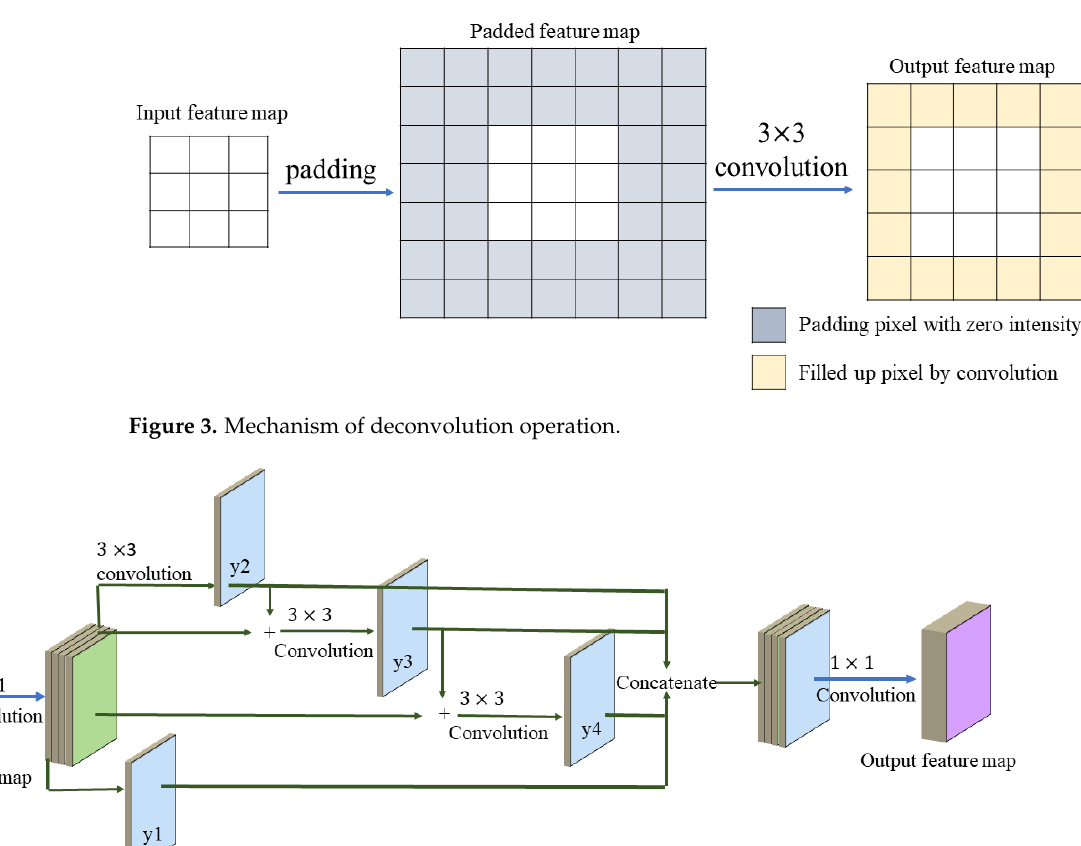
Table 2. General information on each landslide dataset constructed in this study.